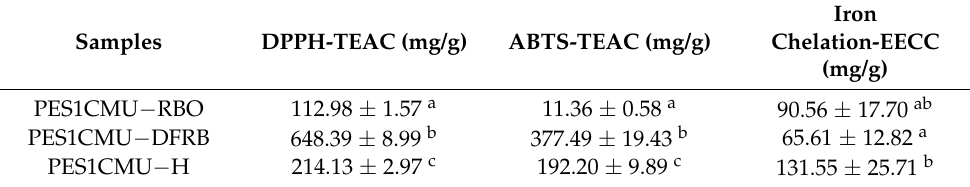
Table 2. DPPH radical scavenging assay, ABTS radical scavenging assay, and iron chelation assay of Oryza sativa L. cv. PES1CMU extracts.